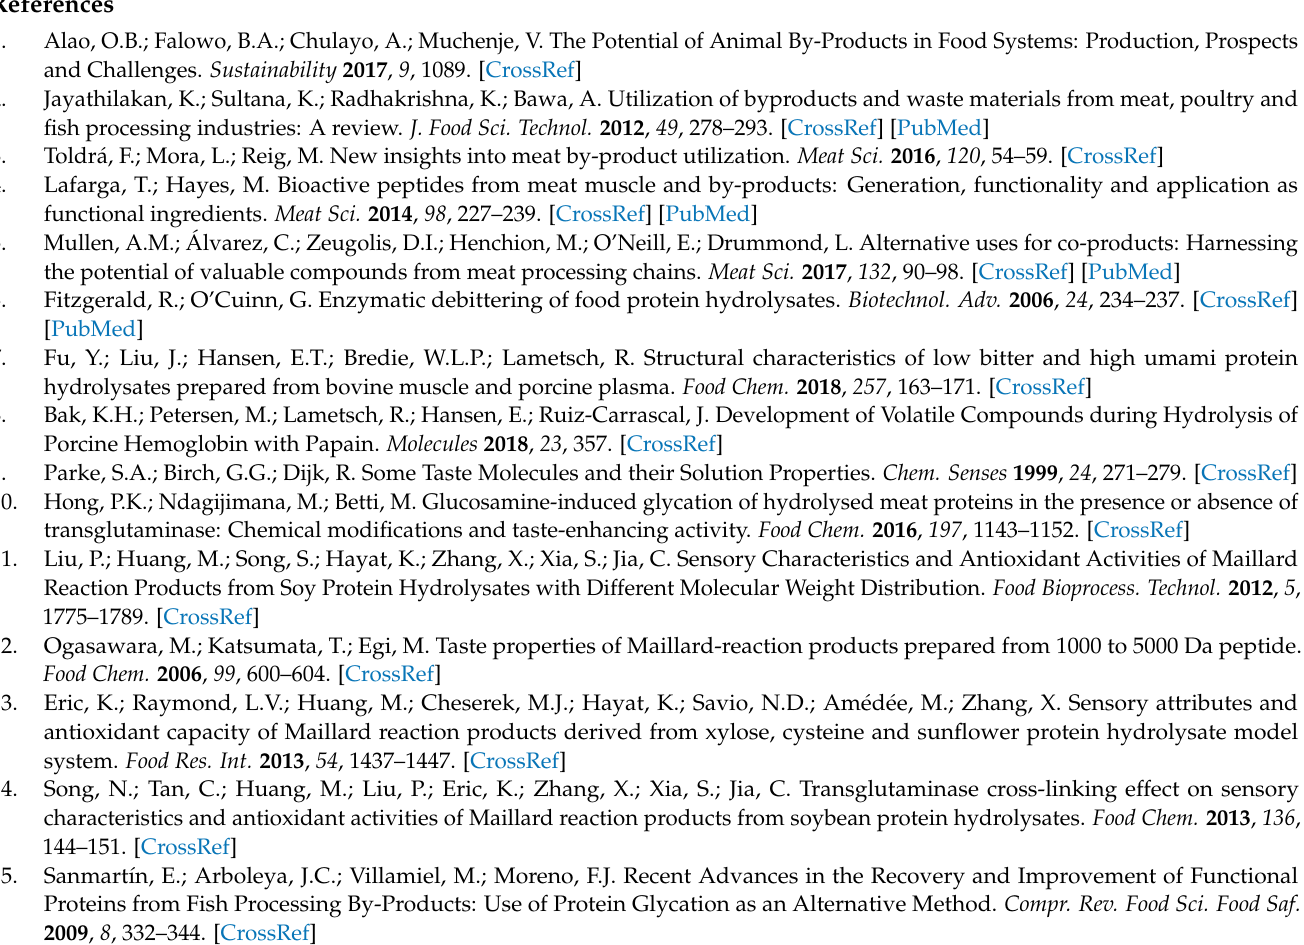
test. Figure S1: Chromatograms showing the volatile composition of hydrolysates of A minced bovine meat (BEEF), B bovine heart (HEART), C porcine hemoglobin (HEMO), and D porcine plasma (PLASMA) in dublicates (A and B) with or without glucosamine